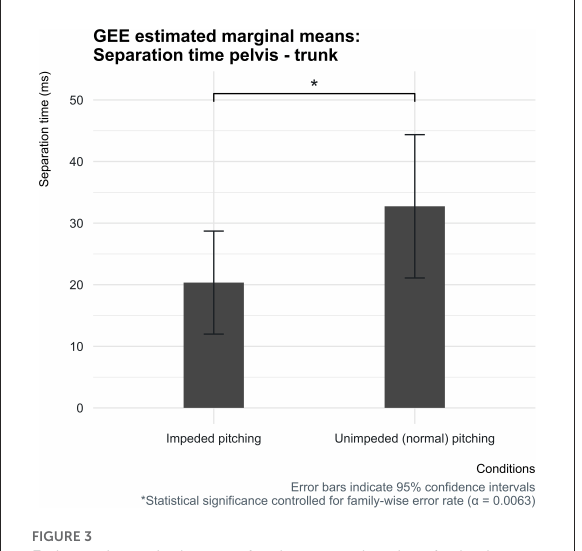
FIGURE3 Estimated marginal means for the separation time for both conditions with corresponding 95% confidence interval error